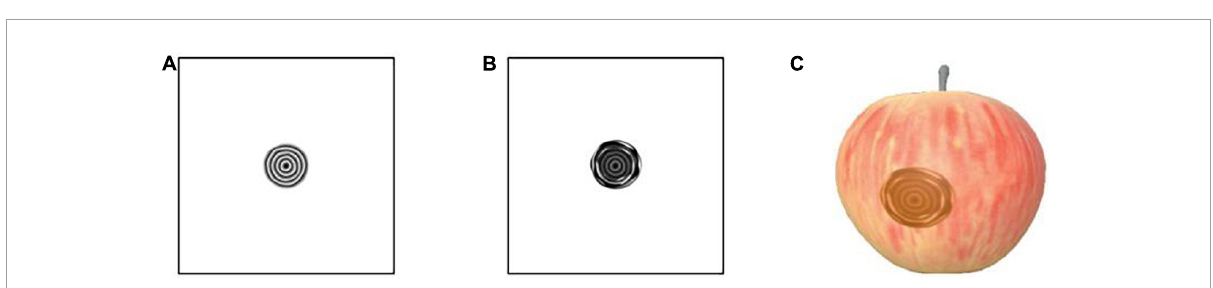
FIGURE4 Generation of initial water stain-like spot.